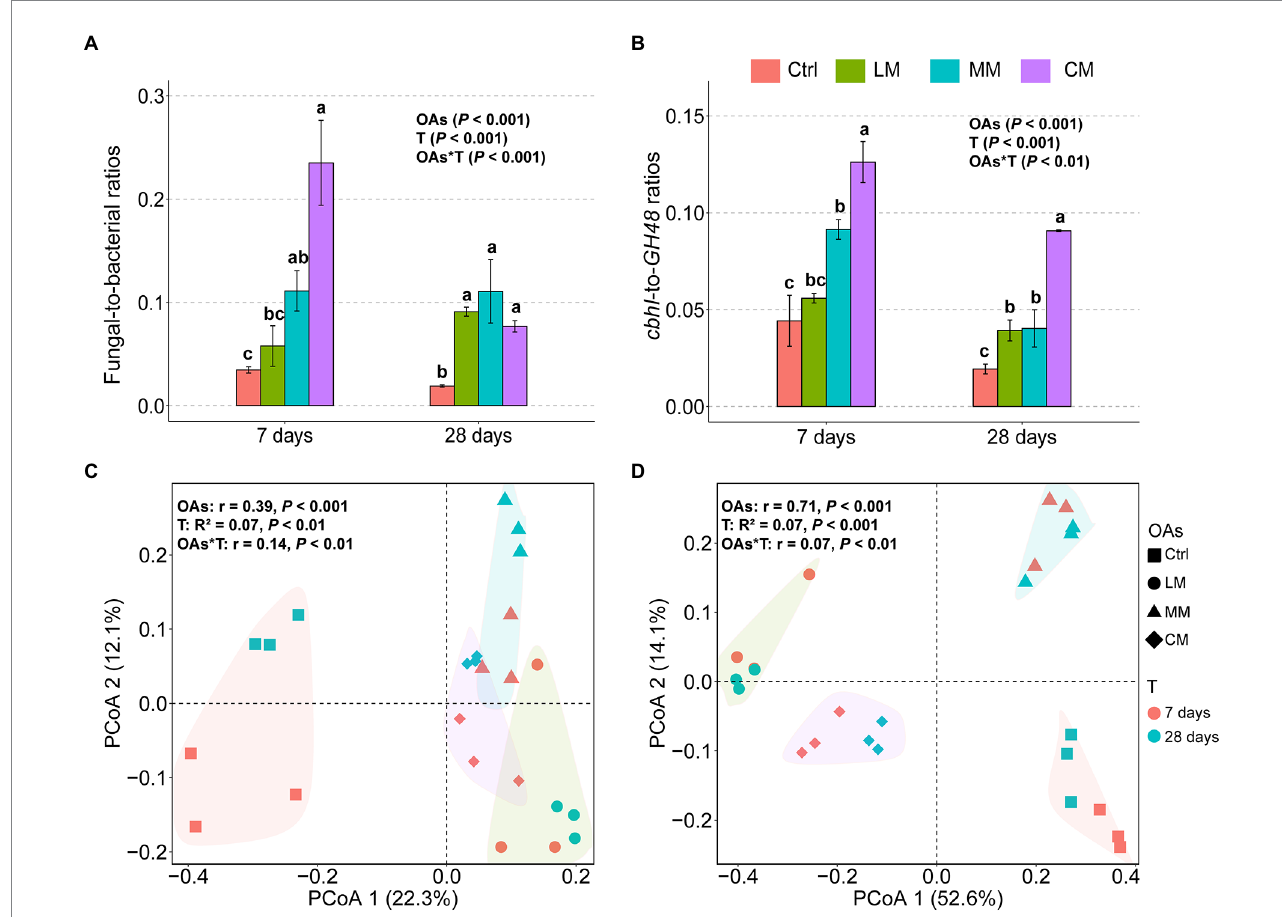
FIGURE 2 Effects of organic amendments (OAs) with different chemical structures on fungal-to-bacterial ratios (F:B) and their C-cycling gene ratios ( cbhI-to-GH48 ratios) as well as bacterial and fungal diversity. (A) The fungal-to-bacterial ratios (F:B) under different OAs. (B) The cbhI-to-GH48 ratios ( cbhI:GH48 ) under different OAs. Data are expressed as means ± SD ( n = 3). Error bars depict standard deviations. Lowercase letters indicate significant differences ( p < 0.05) between the treatments. Principal coordinates analysis (PCoA) of the bacterial (C) and fungal (D) communities with different OAs supplements at days 7 and 28 based on Bray-Curtis distance (d). The polygons indicate a 95% standard error for each treatment. Ctrl, Control without OAs; LM, Addition of lignin- dominant OAs; MM, Addition of OAs with equal content of lignin and cellulose; and CM, Addition of cellulose-dominant